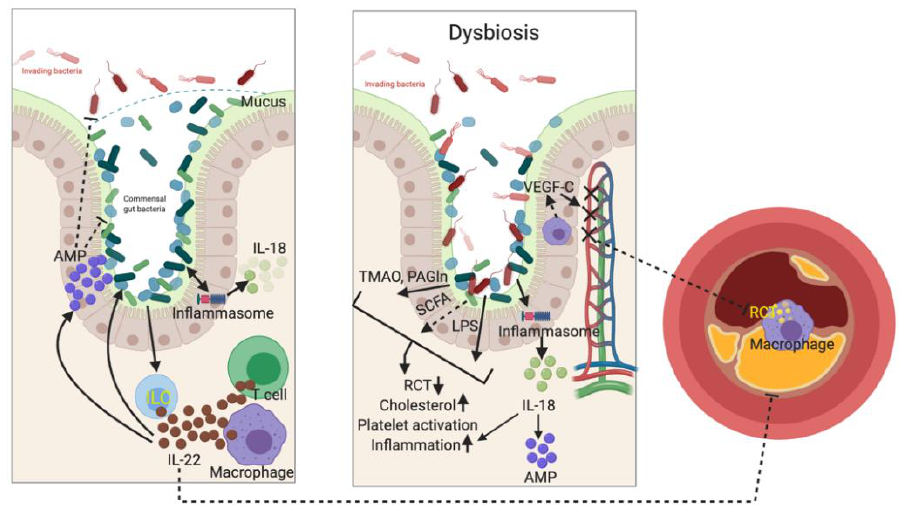
Figure 3. Mutual interplay of microbiota and immune system on atherogenesis.